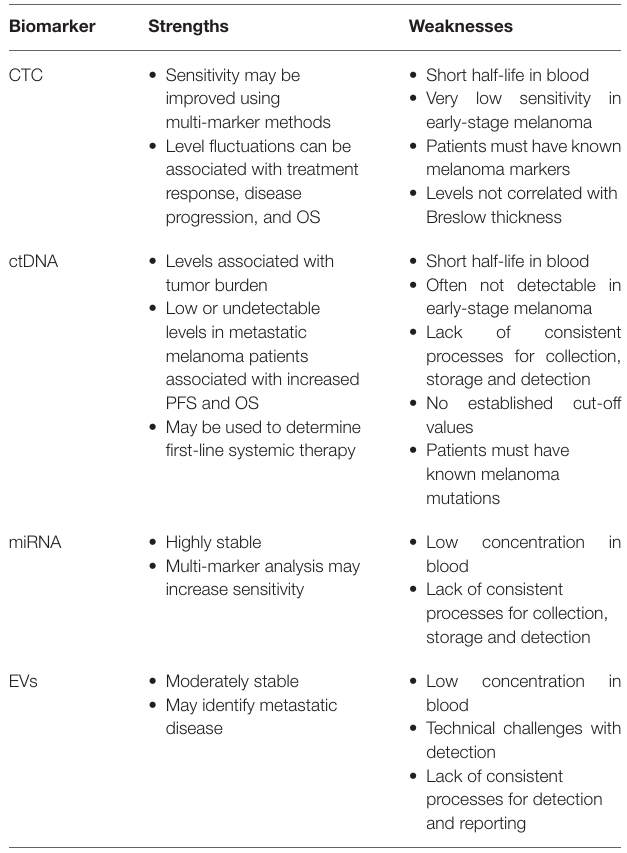
TABLE 2 | Strengths and weaknesses of reviewed melanoma